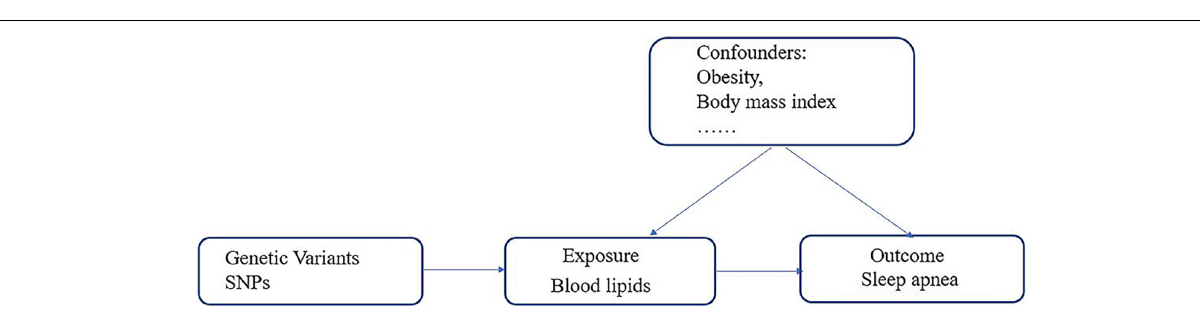
FIGURE 2 | Schematic representation of two-sample Mendelian